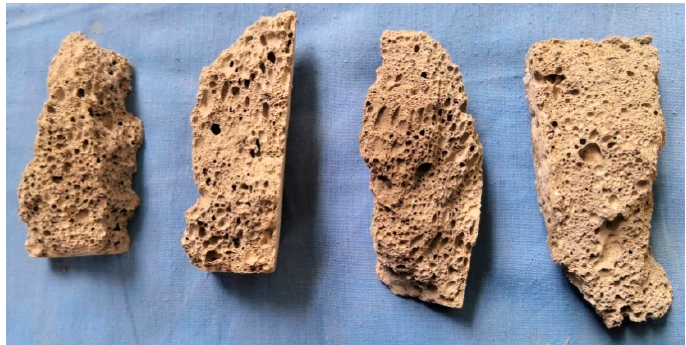
Figure 3. Compression failure characteristics of fly ‐ ash ‐ based foamed geopolymer.